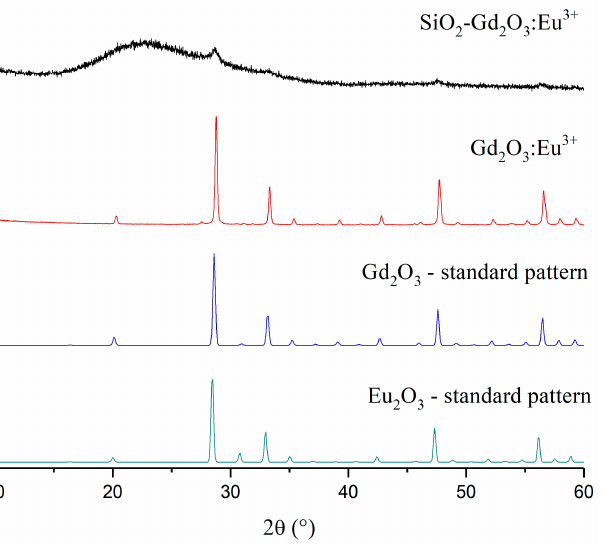
Figure 4. XRD patterns of SiO 2 -Gd 2 O 3 :Eu 3+ (1%), Gd 2 O 3 :Eu 3+ , and crystalline standard phases: Gd 2 O 3 (ICSD#184590) and Eu 2 O 3 (ICSD#194513).